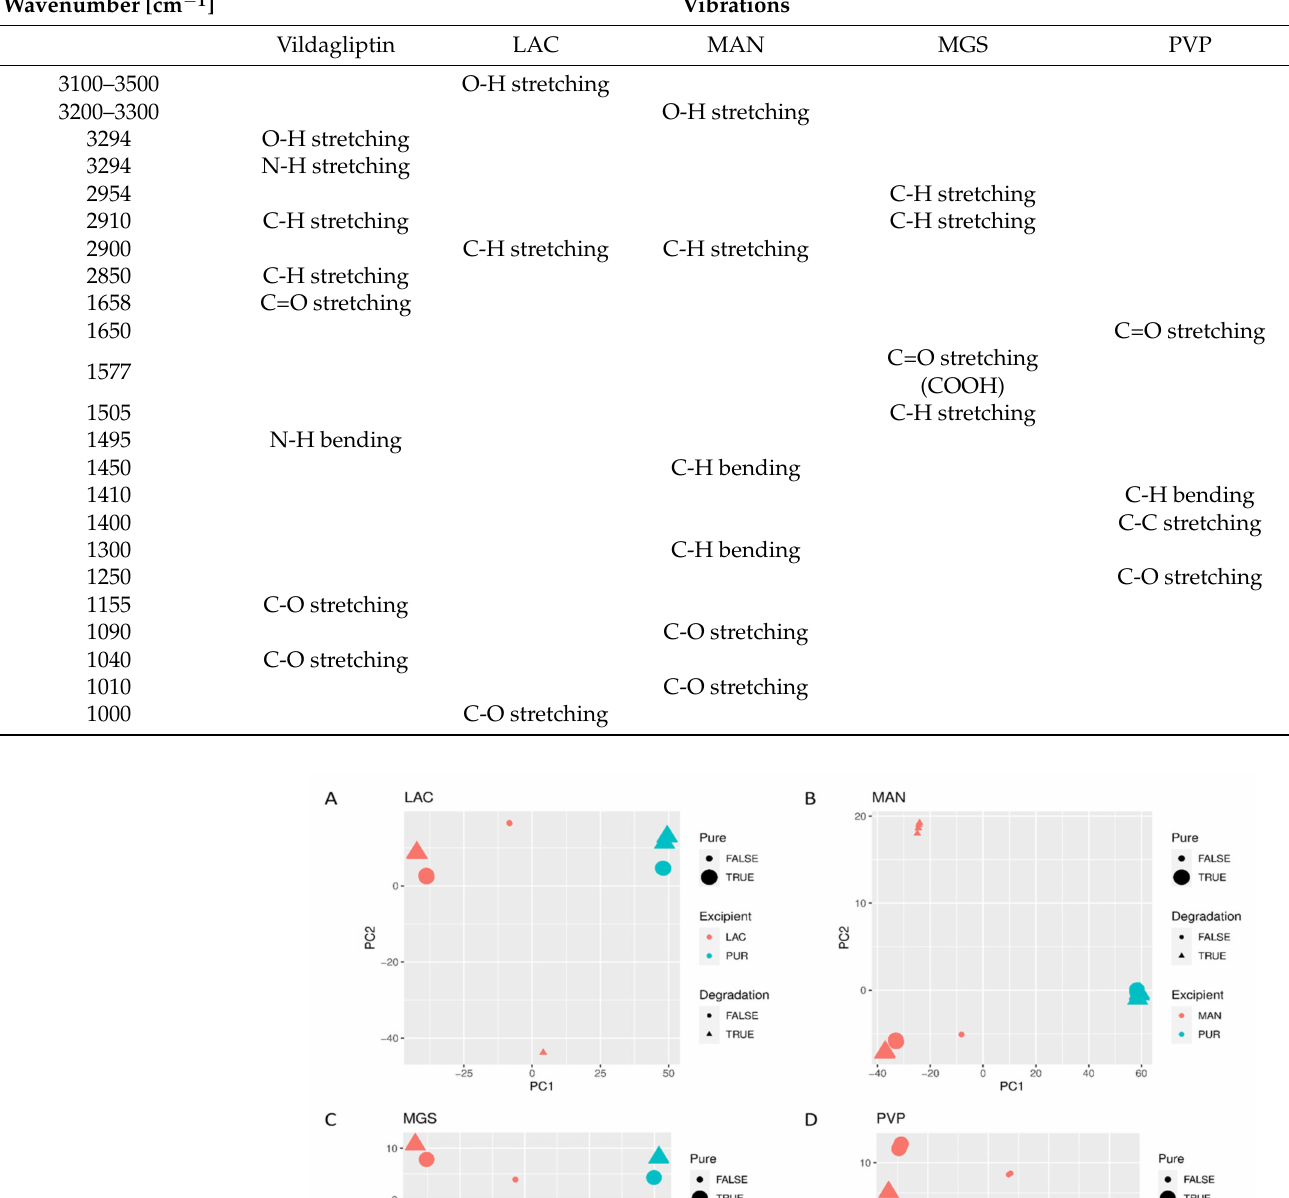
Table 6. Mid-IR characteristics of vildagliptin, lactose (LAC), mannitol (MAN), magnesium stearate (MGS) and polyvinylpir- rolidone (PVP).